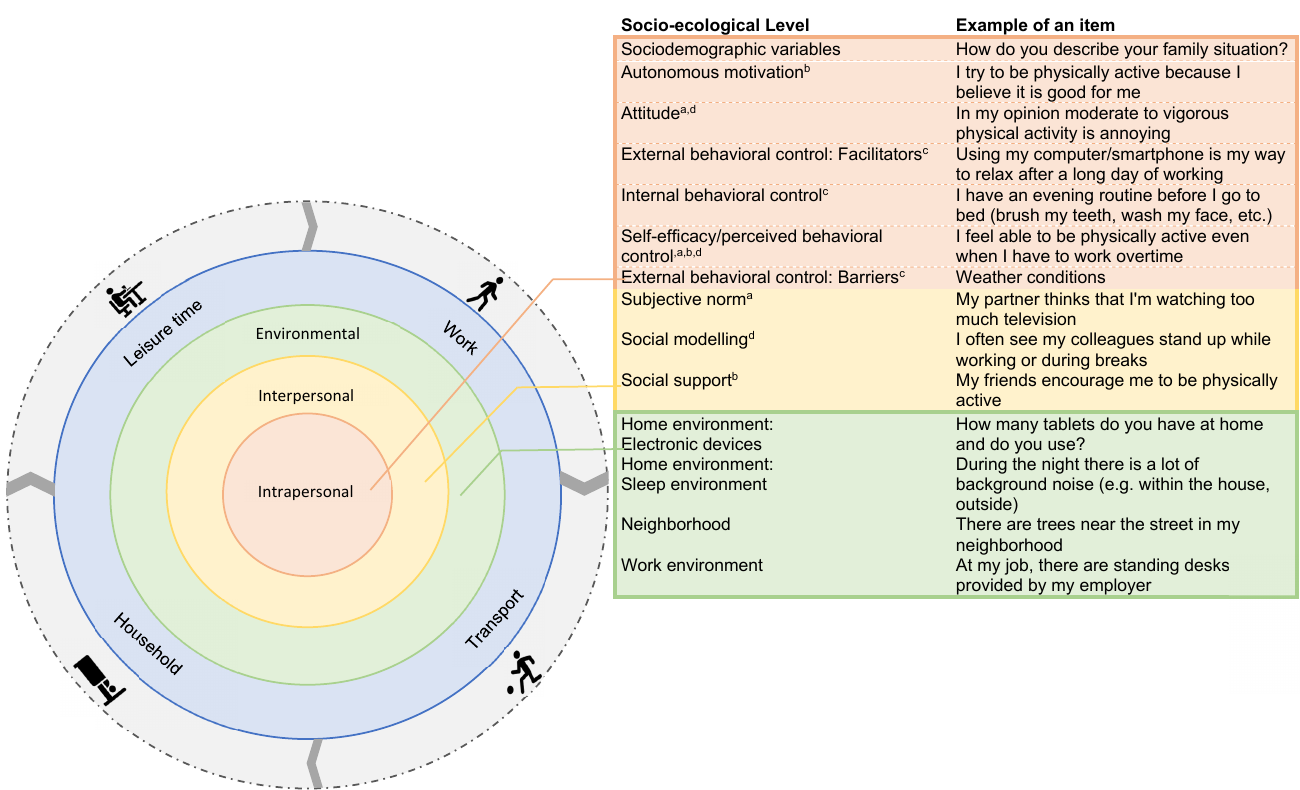
Figure 1. Questionnaire items within the socio-ecological model. The orange zone represents the intrapersonal level. The yellow zone represents the interpersonal level. The green zone represents the environmental level. The blue zone represents the four active living domains. The grey zone represents the 24-h movement behaviors including sleep, sedentary behavior, light physical activity and moderate to vigorous physical activity. The psychological factors questioned in the intra- and interpersonal level are part of a behavior change theory: Theory of Planned Behavior a , Self- Determination Theory b , Dual System Theory c , Social Cognitive Theory d